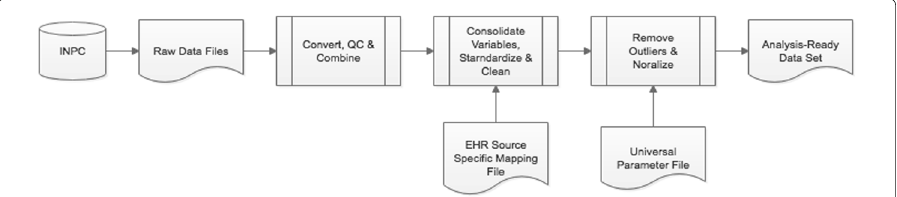
Fig. 1 Above is a flowchart depicting the cleaning and standardization process which (1) combines and QCs the raw data files, (2) combines variables, standardizes, and cleans using a dictionary specific to the data source, and finally (3) removes variable outliers and normalizes using a universal clinical parameter